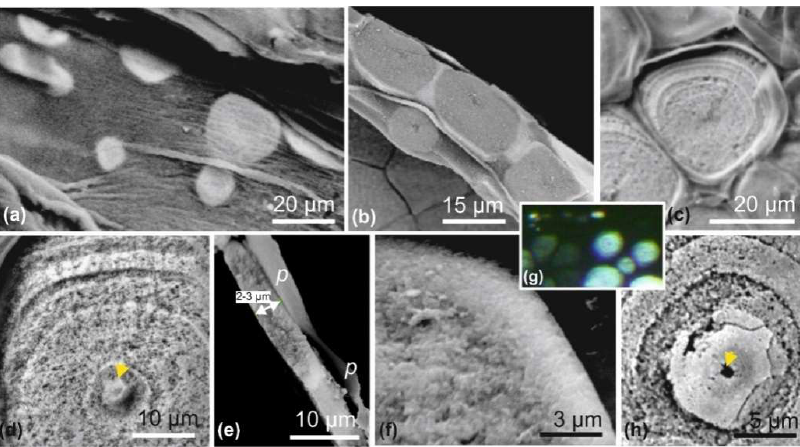
Figure 3. Pinctada margaritifera : disks development and structure. ( a ) Early mineralization stages of the disks. Note the parallel growth striation of the periostracum. ( b ) Almost final growth stages. ( c , d ) Evidence of concentric mineralization. Note the central nodule. ( e ) Growth of the disks is only bi-directional. Up to their last stages they remain thin structures about 3 µ m thick. ( f ) Granular structure of the disks. ( g ) Differences in polarized transmitted light between neighbor disks (similar thickness) suggest distinct crystallographic orientations. ( h ) A partially decayed disk shows the empty place of the initial nodule. Credit pictures: (b,d) [25].